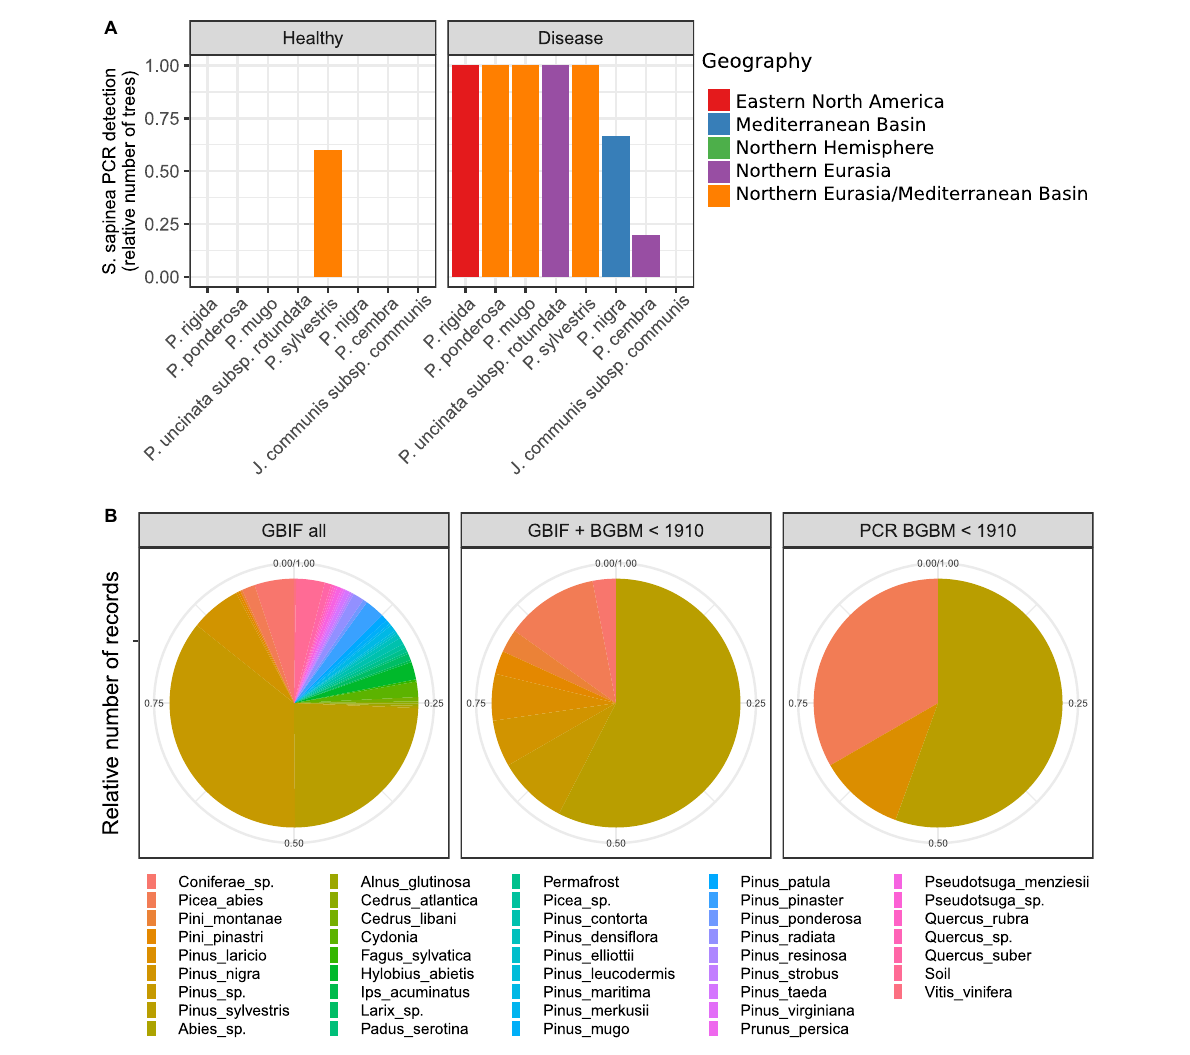
FIGURE3 Distribution of Sphaeropsis sapinea across host pine species. PCR detection of Sphaeropsis sapinea across pine species and needle health status using species-specific DpF-BotR primers. (A) Positive PCR detection of S. sapinea across pine species and health status. Pinus rigida ( n = 2 trees), P. ponderosa ( n = 1), P. mugo ( n = 5), P. uncinata subsp. rotundata ( n = 3), P. sylvestris ( n = 5), P. nigra ( n = 3), P. cembra ( n = 5), Junniperus communis ( n = 1). (B) Host of records of S. sapinea based on all GBIF records (GBIF all; n = 351), on combined data from GBIF and fungarium specimens at Botanical Garden and Botanical Museum (BGBM) of Berlin before 1910 with a recorded host (GBIF + BGBM < 1910; n = 33), and the subset of specimens for which the identity of S. sapinea was confirmed by PCR species-specific assay (PCR BGBM < 1910; n =